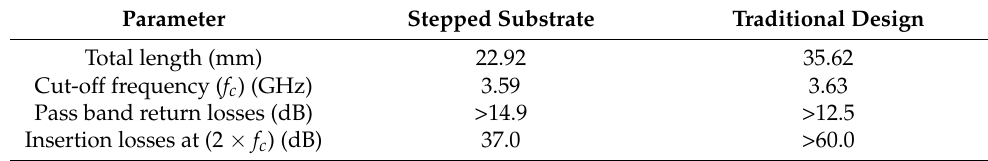
Table 6. Comparison between the stepped substrate low pass filter and the conventional